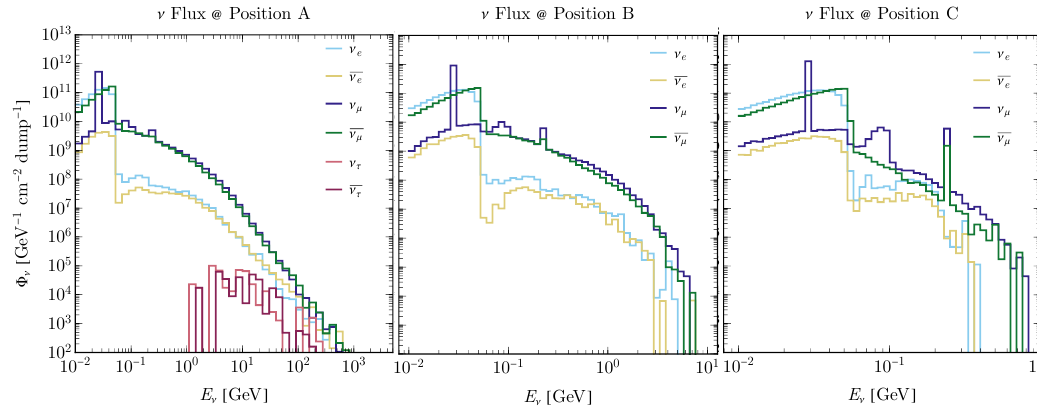
Figure 3. Neutrino fluxes per beam dump at Positions A, B, C as labelled in figure 1 and explained in the text. Different colors correspond to different flavor of neutrino flux, as well as neutrino and antineutrino components. Note the different scales in the x -axis ( E ν ) in the three panels — the flux at Position A extends to significantly higher energy from the decays of very boosted mesons. In contrast, the flux at Position C is described entirely by meson decay-at-rest and muon decays. For reference, we consider an average of two beam dumps per day and 200 days of LHC running per year.